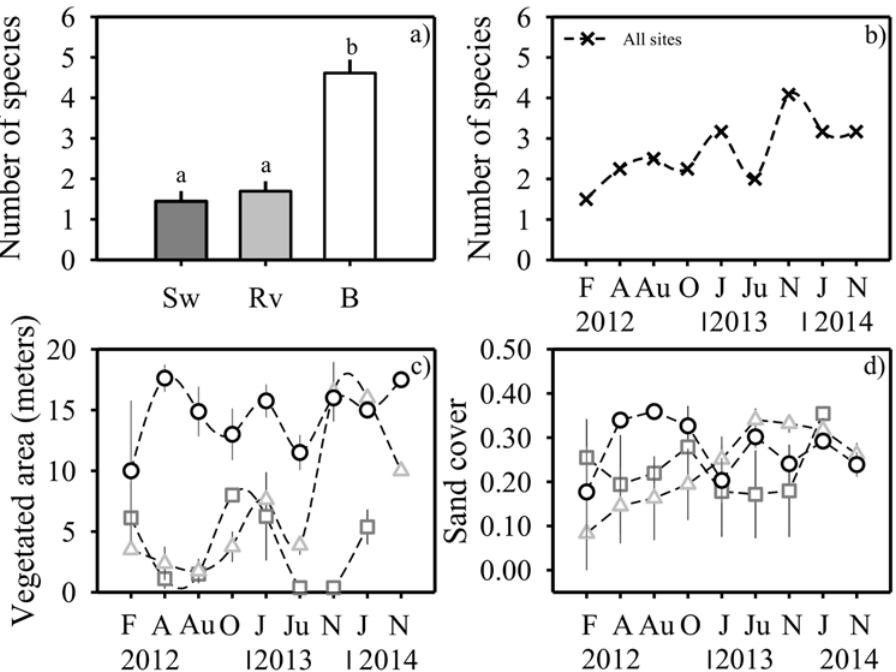
Fig 3. Responses of the plant species and vegetated area to the Maule earthquake. a) Mean (1 + SE, n = 4 transects) number of species at each site, b) total number of species including all sites, c) mean (1 ± SE, n = 4 transects) width of the vegetated area at each site, d) absolute sand cover (standardized mean ± SE, n = 4 transects) of the three study sites over time. The study sites at the beach of Llico are: Sw (in front of a seawall), Rv (in front of a revetment) and B (unarmoured beach). The sampling times were: February (F), April (A), August (Au) and October (O) 2012, January (J), June (Ju), and November (N) 2013, and January (J) and November (N)